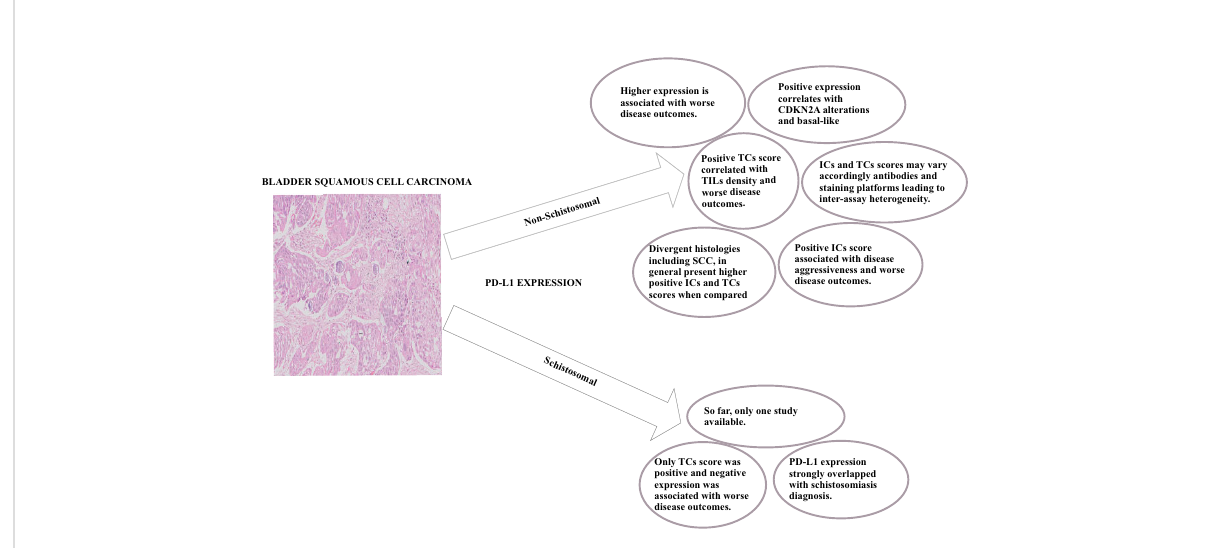
FIGURE 1 Overall key-points regarding PD-L1 expression in Non-Schistosomal and